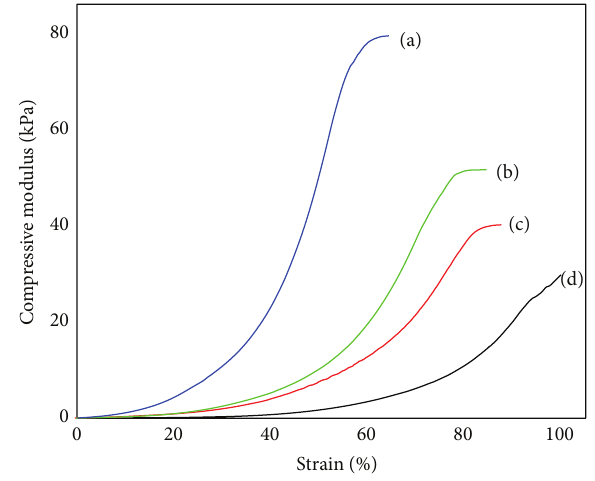
Figure 7: Typical compressive modulus-strain curves of cellu- lose/MWCNTs hydrogels with different weight ratios: (a) Gel 1 (20 :1), (b) Gel 2 (10: 1), (c) Gel 4 (3 :1), and (e) Gel 5 (2: 1) at room